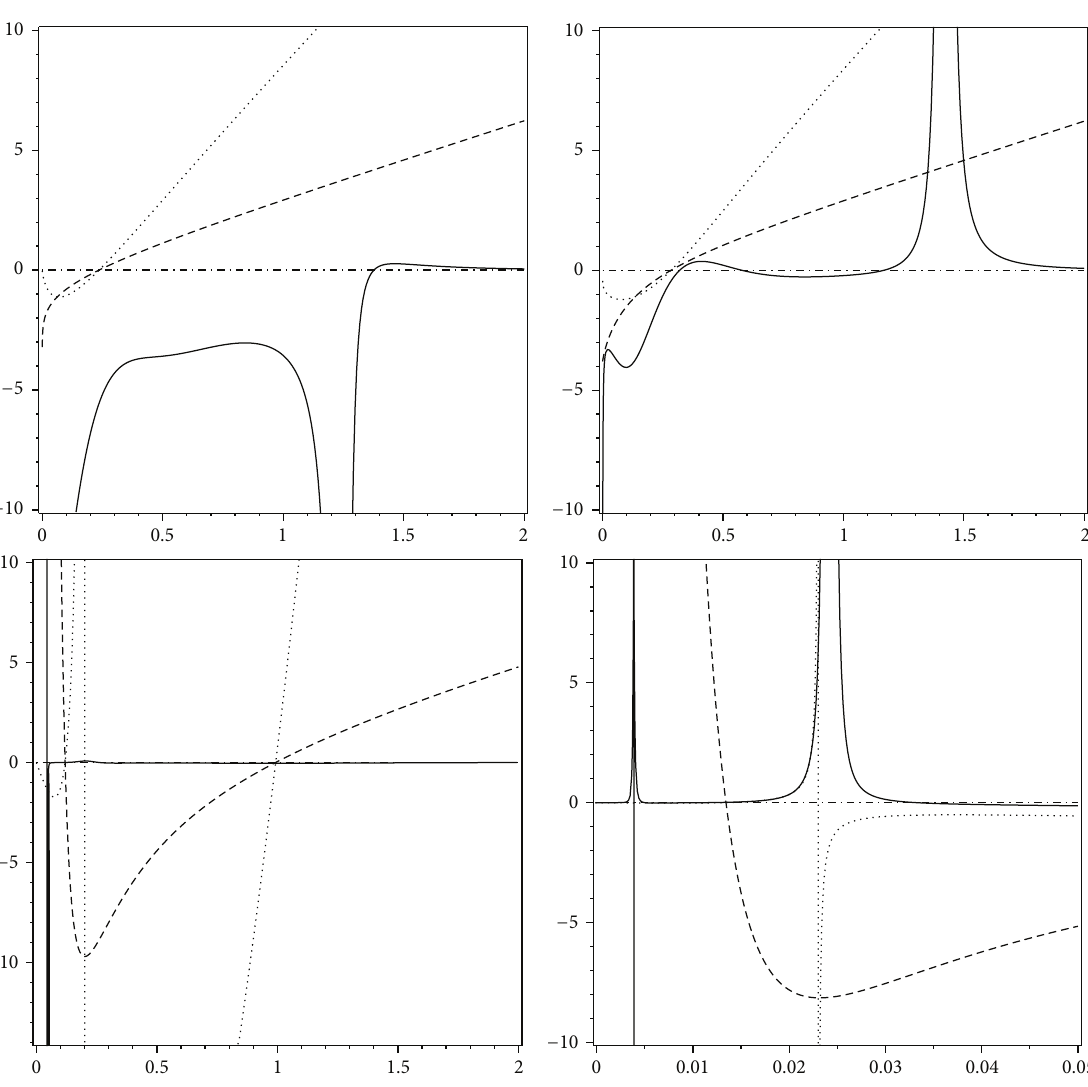
Figure 1: Weinhold Ricci scalar (solid line), heat capacity (dotted line), and temperature (dashed line) versus 𝑆 for 𝑙 = 1. HNED model (up- left panel) and SNED model (up-right panel): 𝑞 = 0 . 3, 𝛽 = 1. CNED model (down-left panel) and CNED model (down-right panel): 𝑞 = 1, 𝛼 = 0 . 007 (different